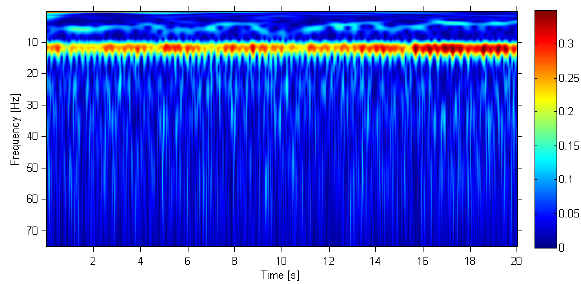
Figure 7. Morlet-scalogram of the acceleration in flight